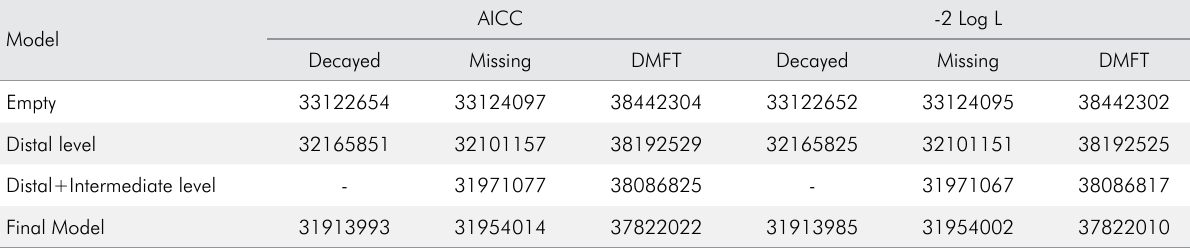
Table 1. Goodness of fit ( Akaike information criterion – AICC; -2 Log